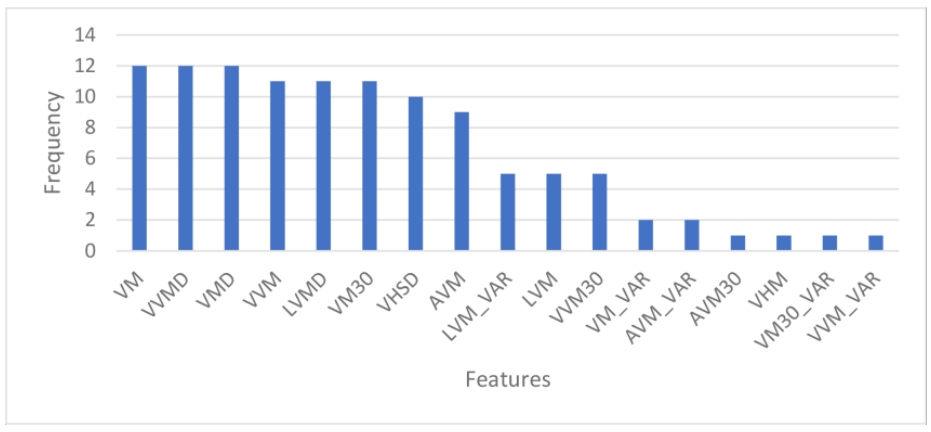
Figure 7. Frequency of features selected by ENET.